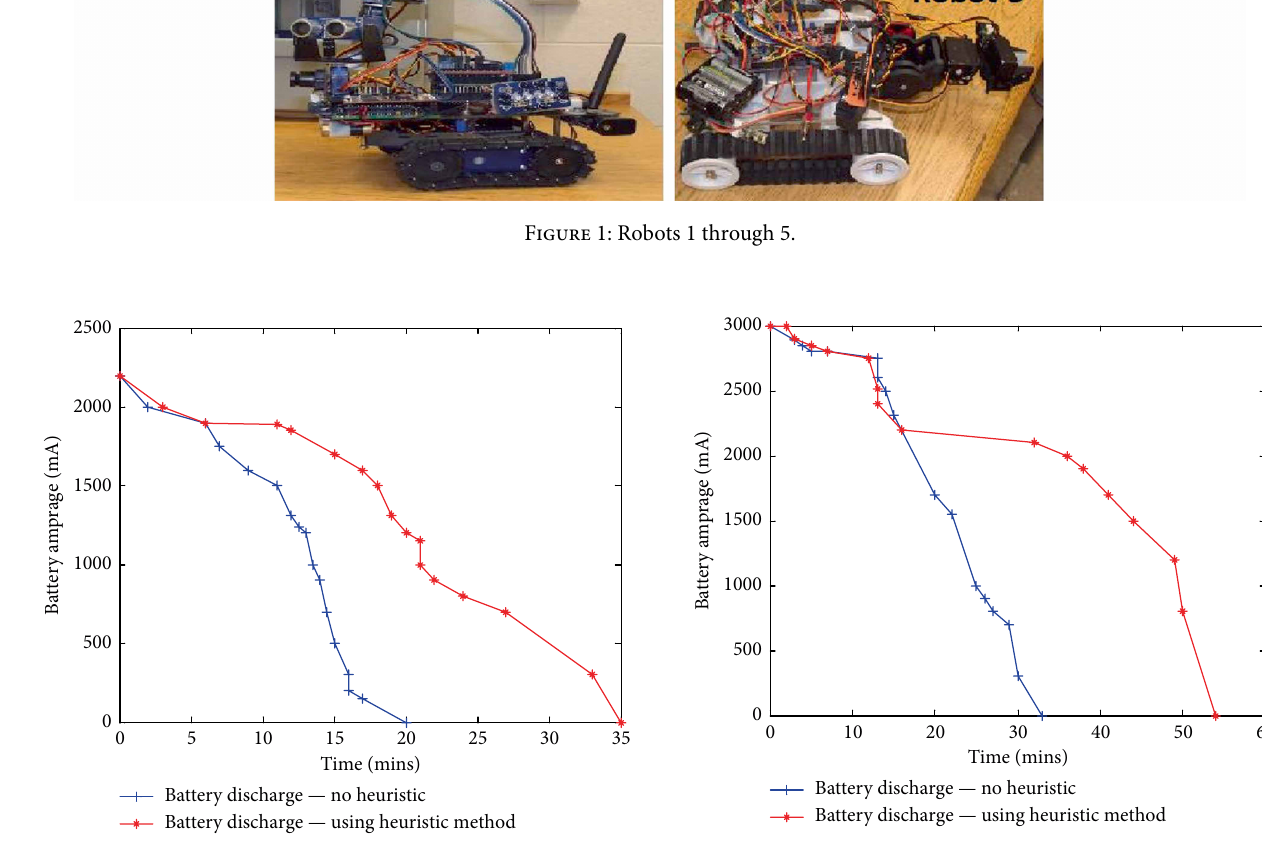
Figure 2: Battery discharge for robot 1. Figure 3: Battery discharge for robot